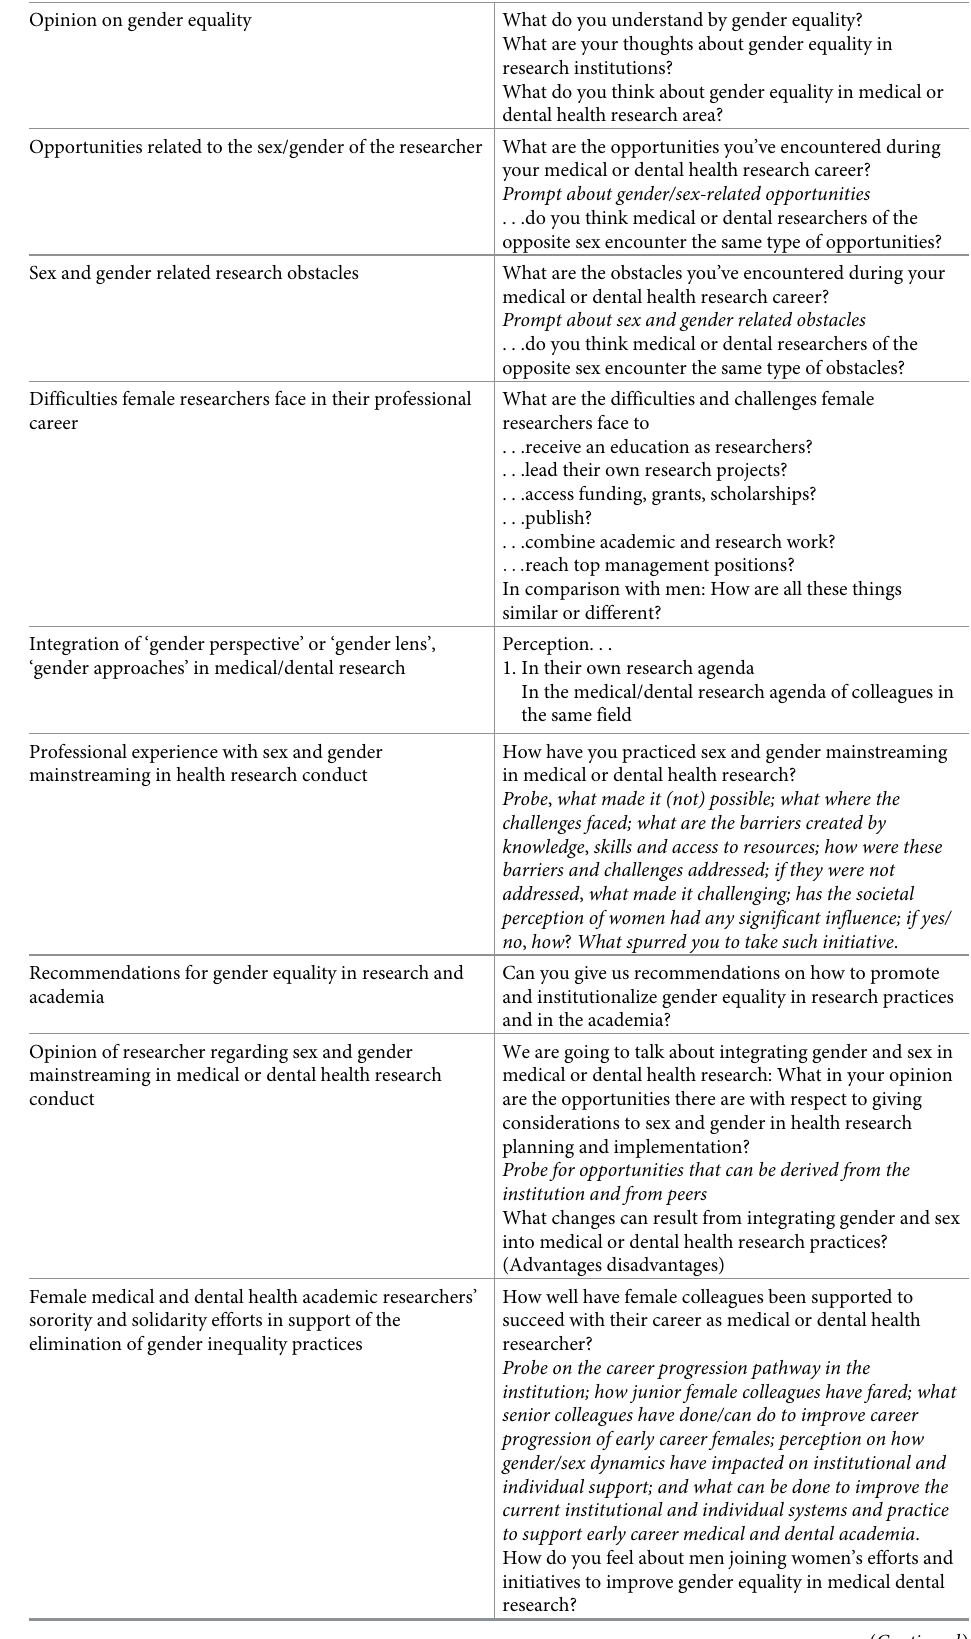
Table 1. Ten broad topics included in the discussion